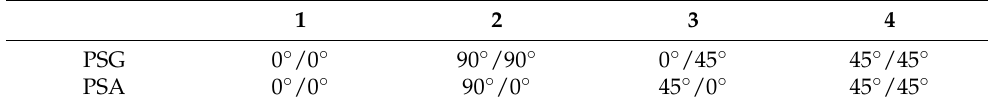
Table 1. Angles of the polarizers and quarter-wave plates in MM imaging